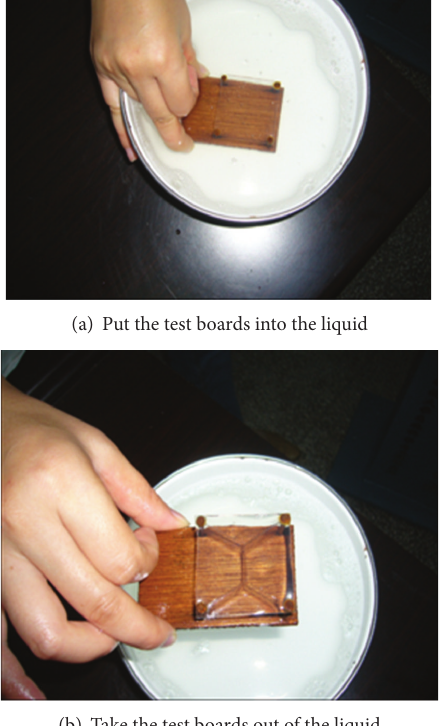
Figure 1: The process of the exploratory